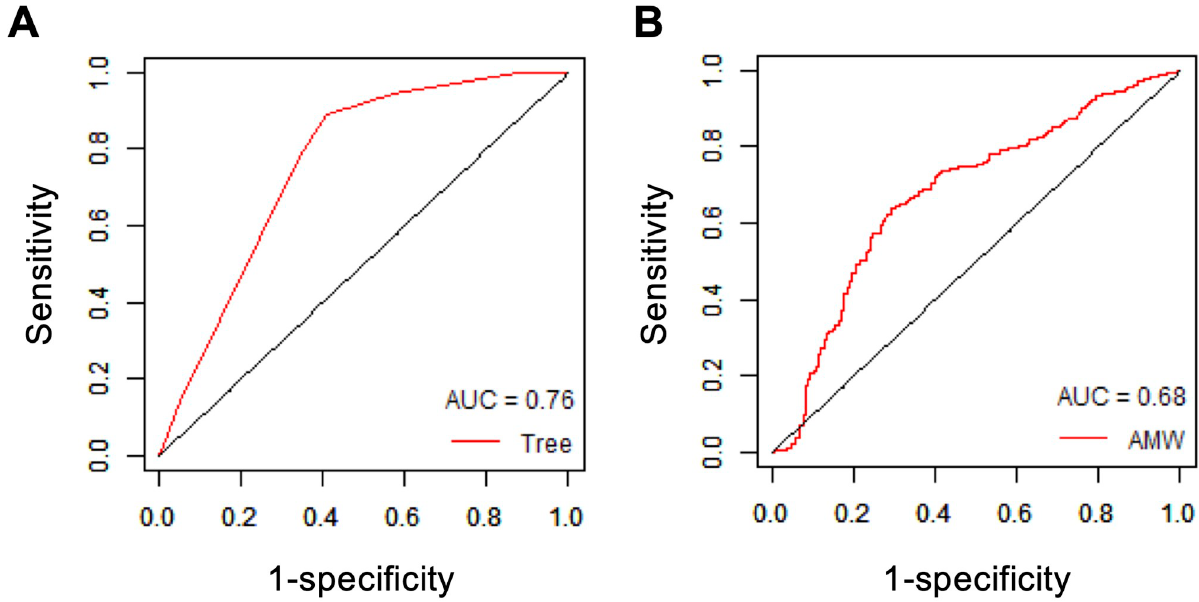
Fig 4. ROC analyses. ROC-AUCs were calculated by discriminating between DILI drugs and no-DILI drugs using the final tree model (A) and AMW alone as an index (B) as described in Materials and Methods.